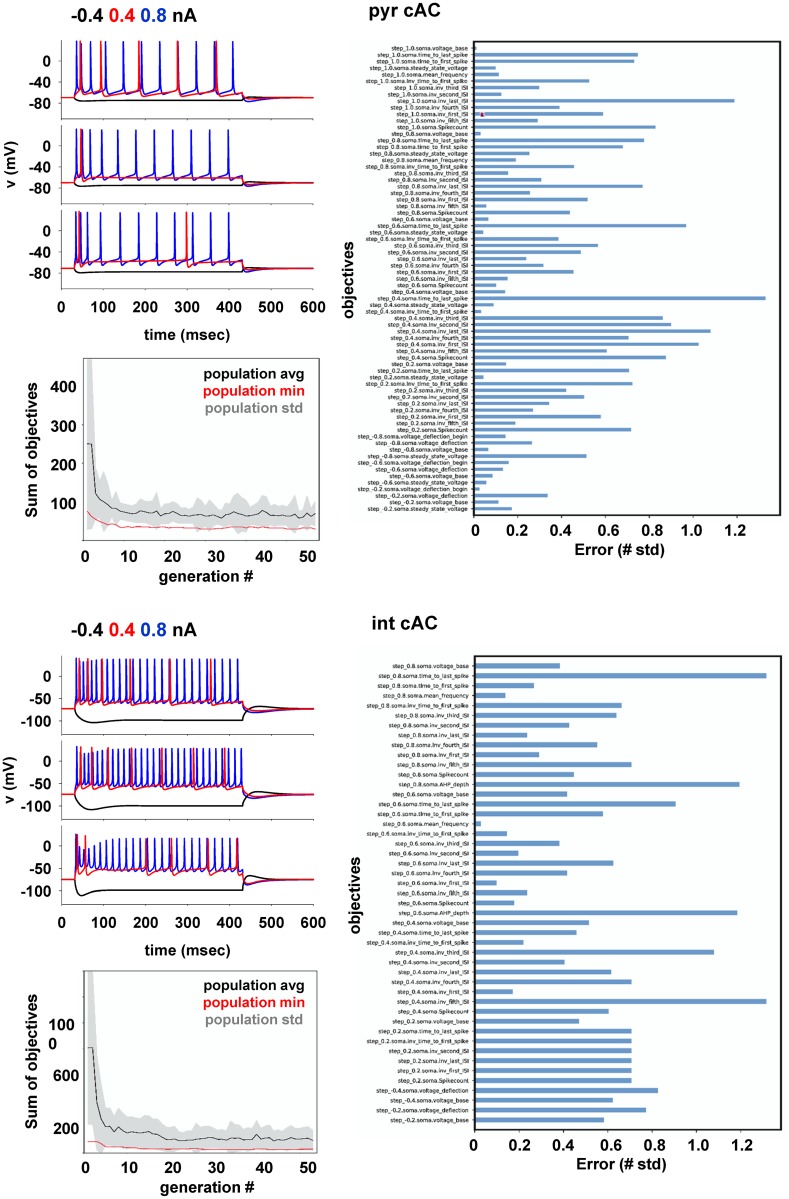
Model optimization.Typical optimization results for cAC pyramidal cells (top) and interneurons (bottom). The top left graph of each panel shows a few examples of model traces from three individuals during a current injection of -0.4, 0.4, and 0.8 nA (black, red, and blue traces, respectively). The right graph of each panel reports the objective scores for the best individual. The bottom left graph in each panel shows a typical evolution of the total score during an optimization run.